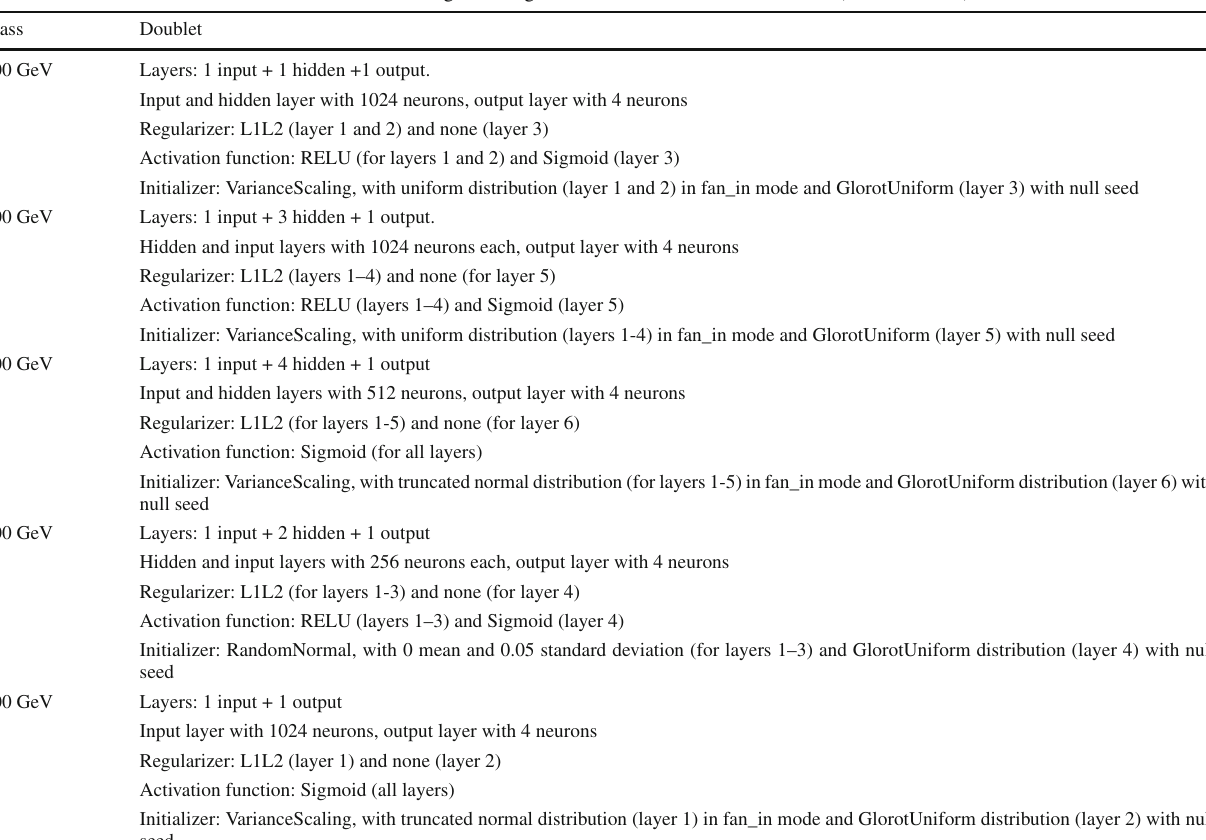
Table 8 Architectures for the neural networks that the genetic algorithm finds for the scanned masses (100–500 GeV) of the doublet VLL